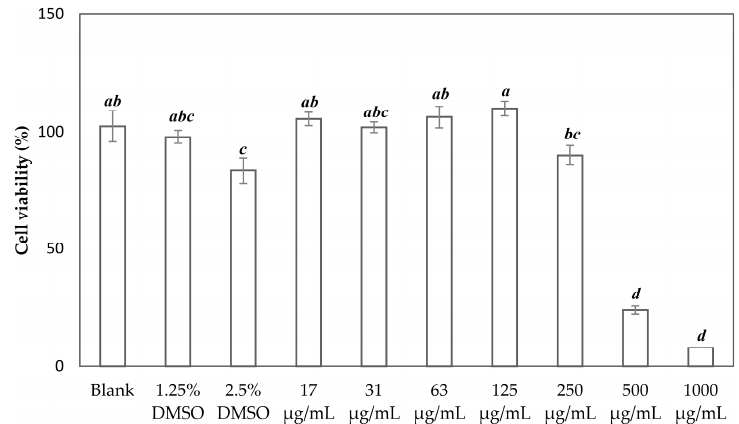
Figure 6 . L929 cell viability after 24-h treatment with shell extracts of different concentrations. Mean Figure 6. L929 cell viability after 24-h treatment with shell extracts of di ff erent concentrations. Mean followed by the same letter(s) are not significantly di ff erent at the 5% level by Tukey